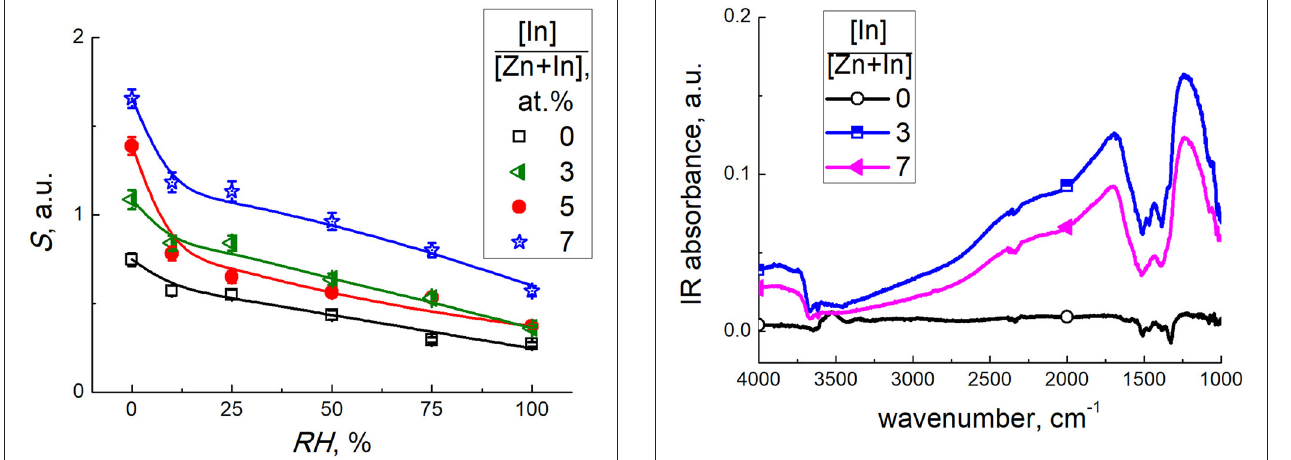
FIGURE 12 | DRIFT spectra of zinc oxide modified by different amounts of In 2 O 3 , exposed to 200 ppm CO at 150 ◦